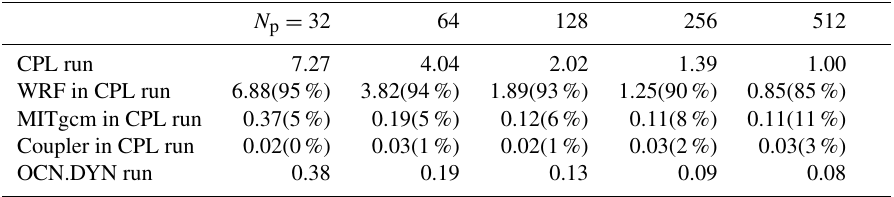
Table 4. Comparison of CPU time spent on coupled and stand-alone runs. The CPU time presented in the table is normalized by the time spent on the coupled run using 512 CPU cores. The CPU time spent on two stand-alone simulations are presented to show the difference between coupled and stand-alone simulations. N p = 32 64 128 256 512 CPL run 7.27 4.04 2.02 1.39 1.00 WRF in CPL run 6.88(95%) 3.82(94%) 1.89(93%) 1.25(90%) 0.85(85%) MITgcm in CPL run